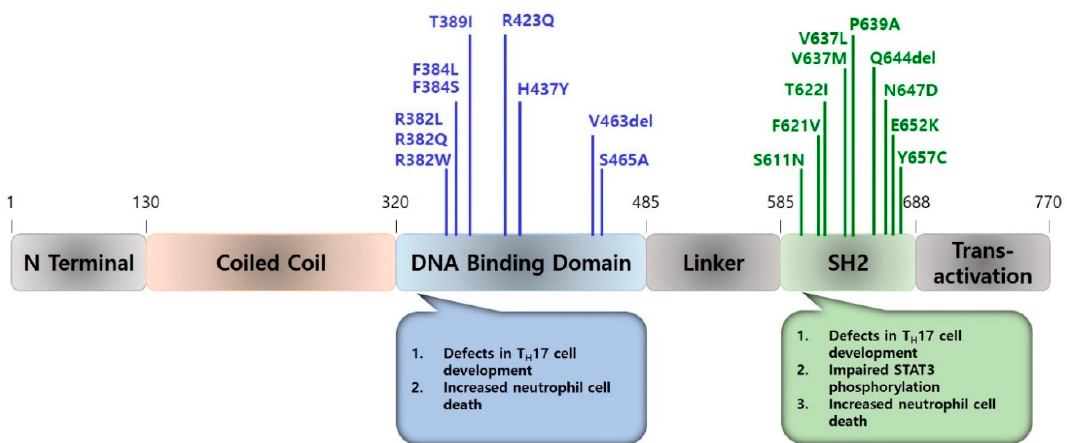
Figure 1. Schematic structure of mutations in STAT3 . Previously described mutations, which are likely involved in recurrent S. aureus infections in HIES patients, are shown in the upper part of the figure. The lower part of the figure described the relevant abnormalities involved in staphylococcal infections of HIES